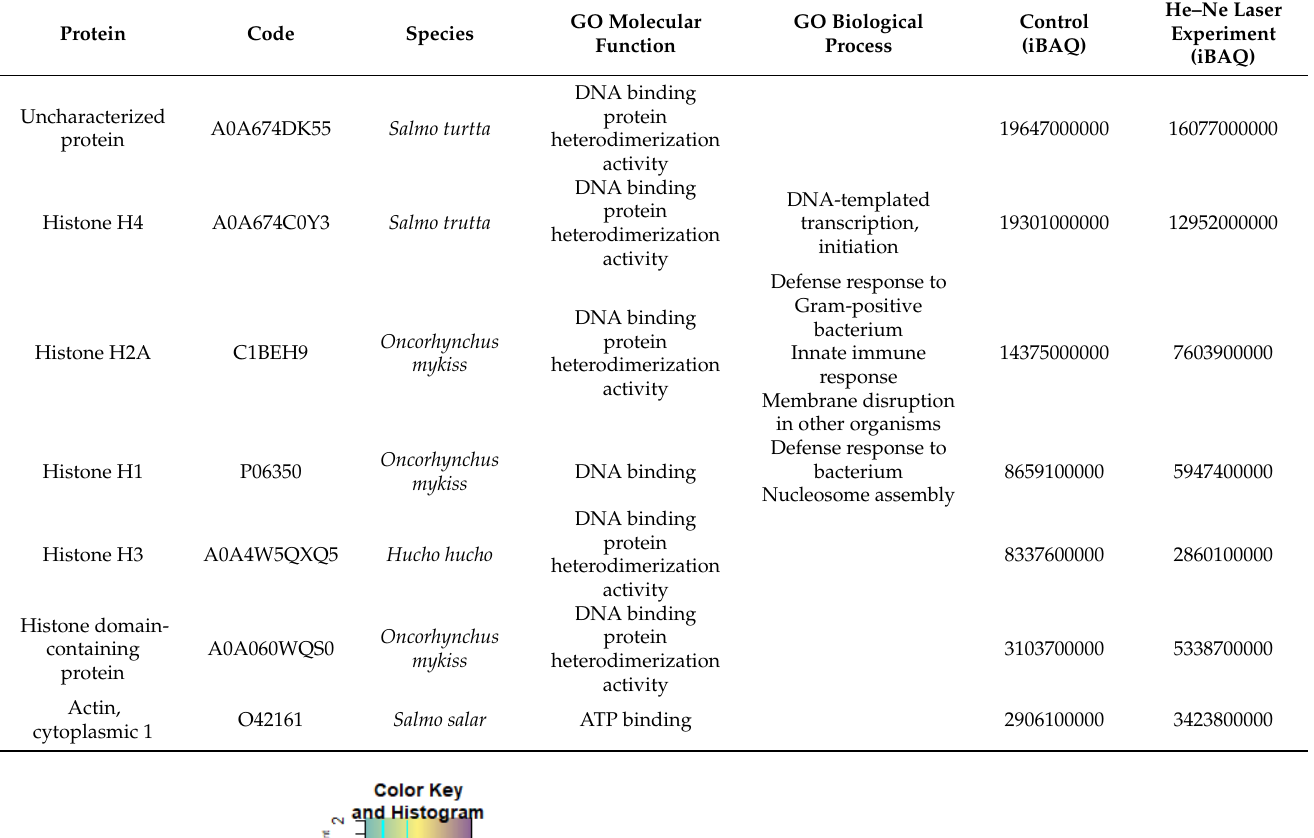
Table 7. The content of highly abundant proteins in underyearlings of Atlantic salmon ( Salmo salar L.).